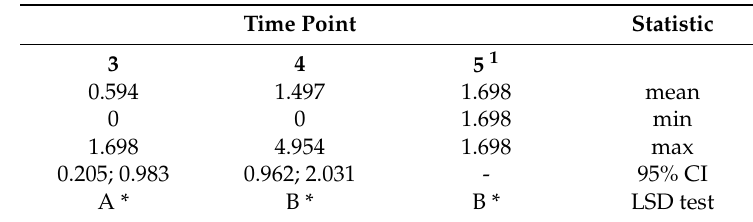
Table 4. Descriptive statistics for rearing period one with the respective mean, minimum, and maximum, as well as 95% confidence interval (CI) presented as log CFU/g caecal content at each sampling point for quantitative analysis and the result of the least significant difference (LSD)